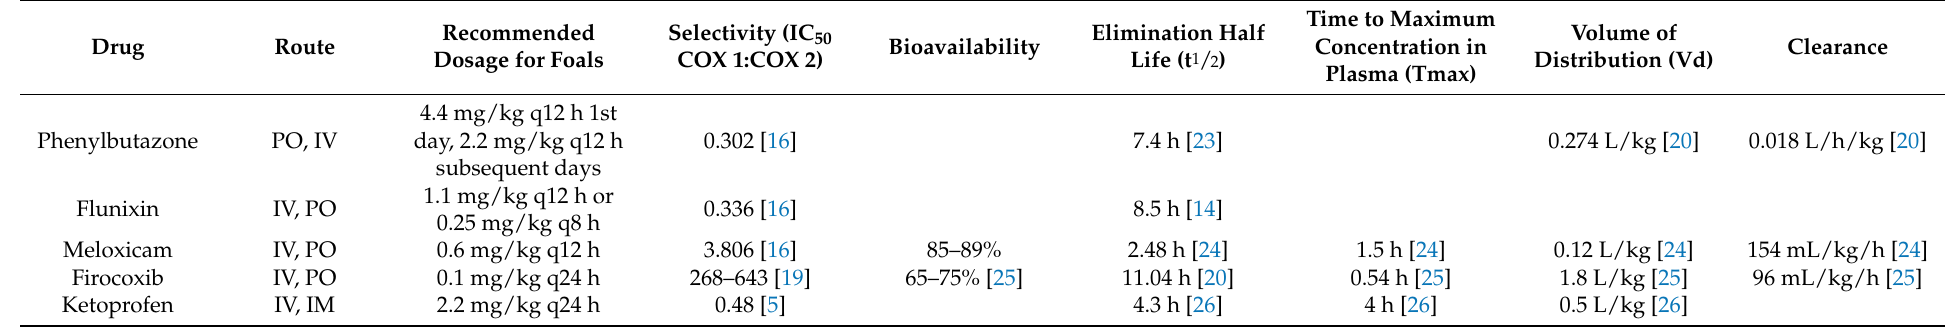
Table 2. Route, recommended dose, IC 50 COX 1:Cox 2 selectivity, bioavailability, elimination half life, time to maximum concentration (tmax), volume of distribution (Vd) and clearance of common NSAIDs used in equine practice in foals under one month of